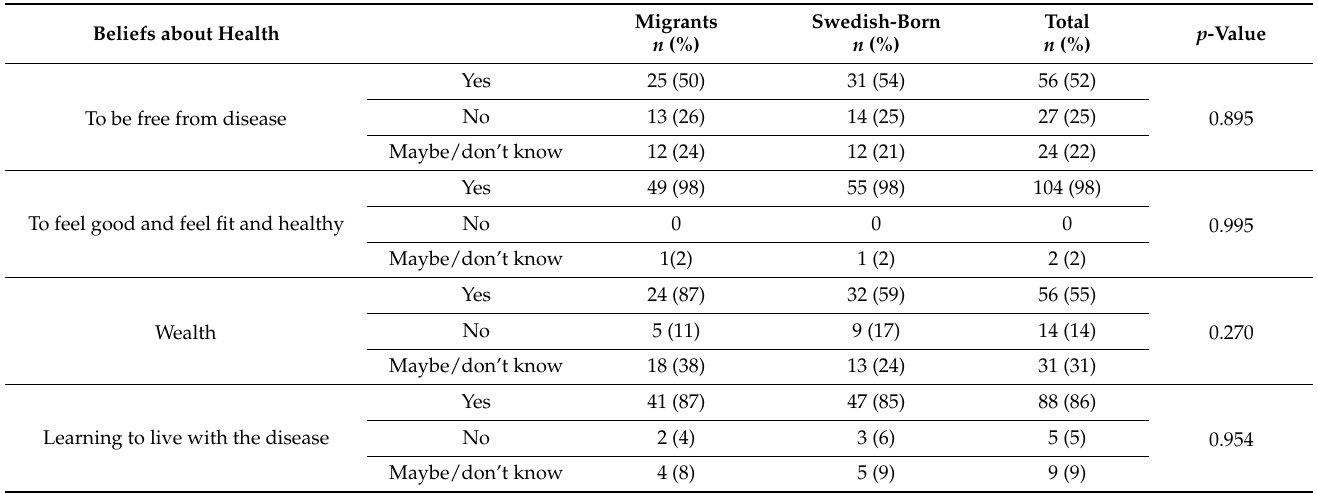
Table 4. Beliefs about what health mean in migrants and Swedish-born persons with type 2 diabetes living in